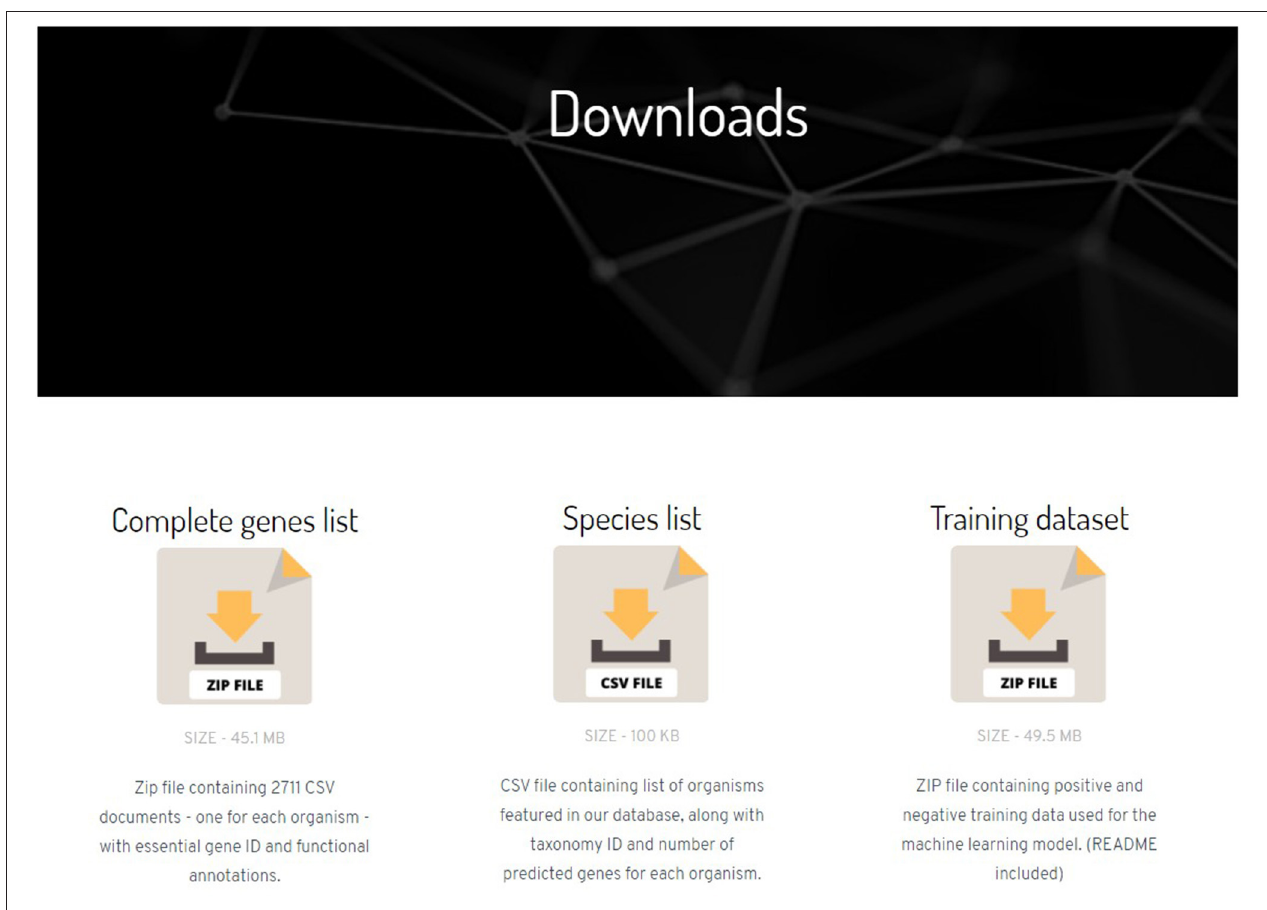
FIGURE 2 | Screenshot of Downloads page in the NetGenes